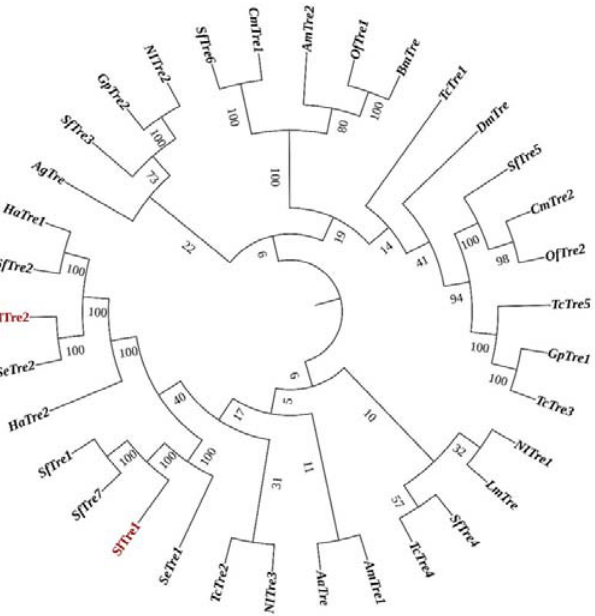
Figure 2. Phylogenetic analysis of trehalases in different species based on amino acid sequences. Tribolium castaneum (Tc), Bombyx mori (Bm), Aphis glycines (Ag), Spodoptera exigua (Se), Helicoverpa armigera (Ha), Aedes aegypti (Aa), Apis mellifera (Am), Drosophila melanogaster (Dm), Locusta migratoria manilensis (Lm), Nilaparvata lugens (Nl), Omphisa fuscidentalis (Of), Cnaphalocrocis medinalis (Cm), Glyphodes pyloalis (Gp), Spodoptera frugiperda (Sf), Anopheles gambiae (Ag), Spodoptera litura